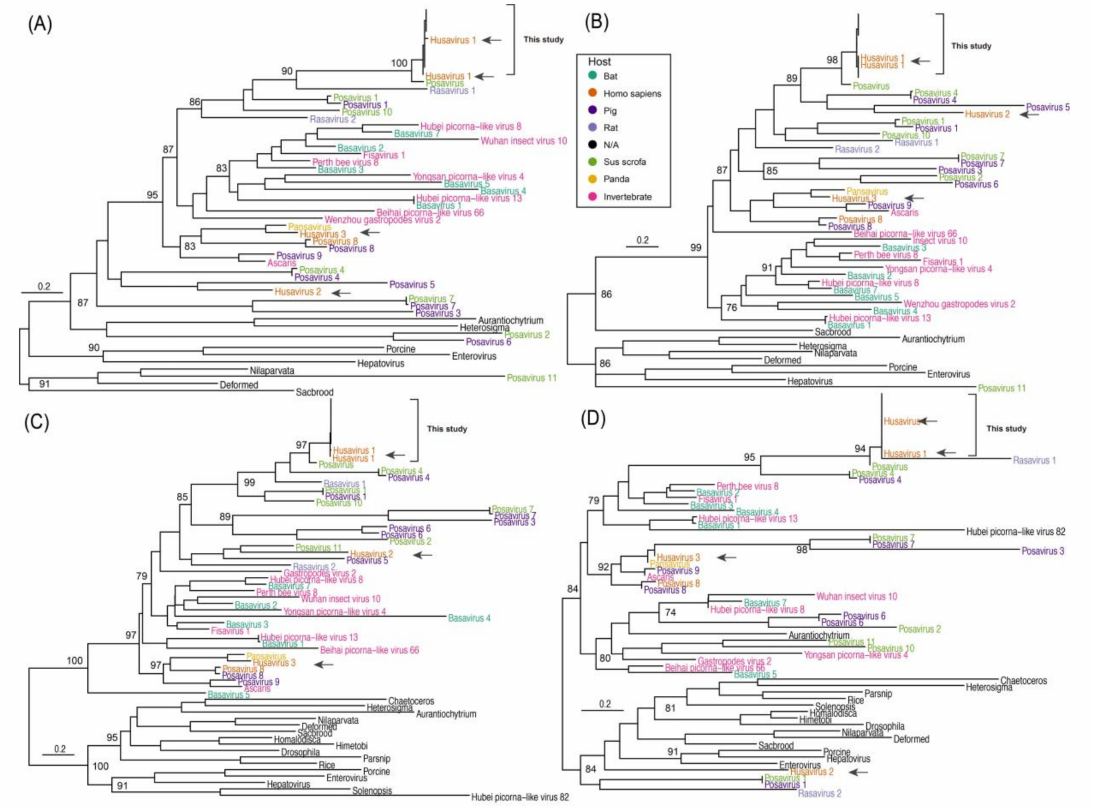
Figure 1. Maximum-likelihood phylogenetic tree of di ff erent conserved domain amino acid sequences. ( A – D ) show the phylogenetic trees based on the picorna-like capsid protein domain 1, picorna-like capsid protein domain 2, RNA-dependent RNA polymerase, and helicase, respectively. The black arrows represent the major husaviruses reported, and the box shows the husavirus strains besides the previously reported Husavirus 1. The genomes of six known families of Picornavirales were used as outgroups. The names are colored according to the types of hosts in the inset. Scale bars indicate the substitutions per site per year. The numbers at each node indicate the bootstrap support value, with 1000 bootstrap